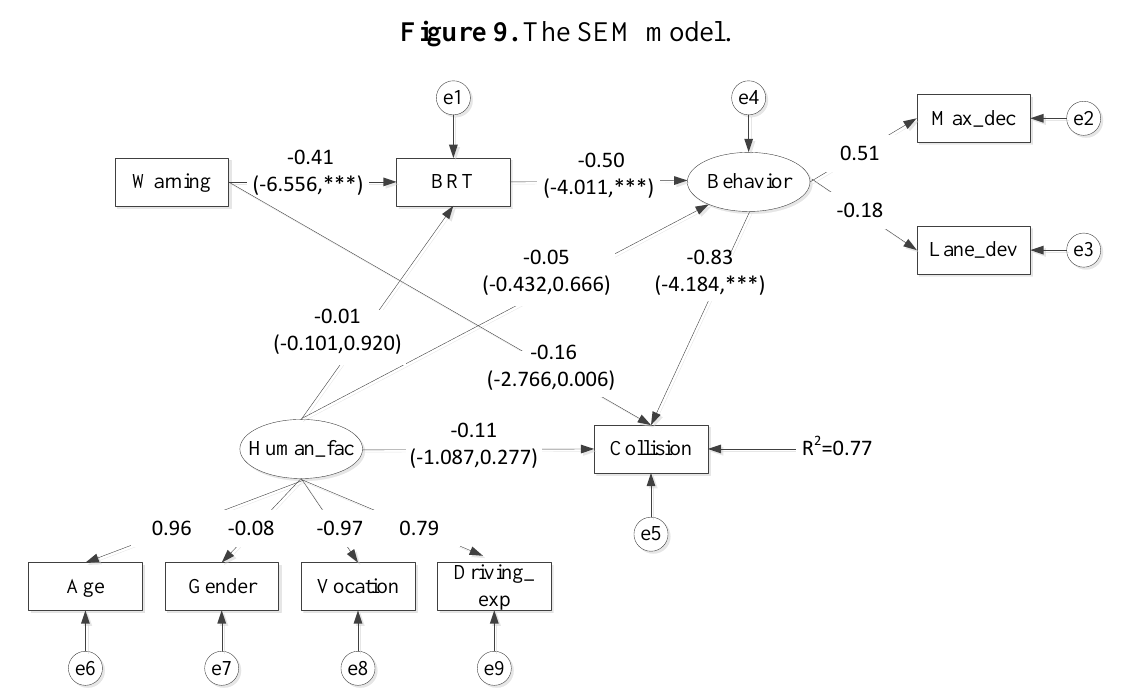
Figure 9. The SEM